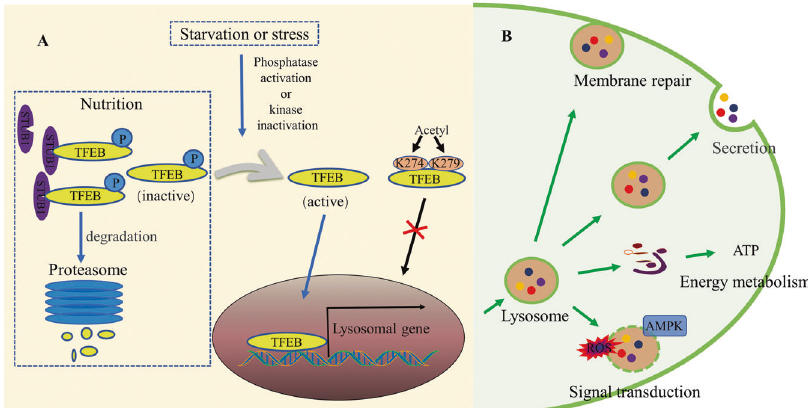
Fig. 1 Schematic diagram of TFEB regulation and lysosomal function. A Under physiological (nutrient) conditions, phosphorylated TFEB is inactive and degradation occurs via the proteasomal pathway. Under starvation or stress, TFEB is activated by kinase inactivation or phosphatase activation-mediated dephosphorylation, and is subsequently transferred to the nucleus to upregulate the expression of its target genes. TFEB acetylation at K274 and K279 blocks TFEB nucleation 28 – 31,33 . B Lysosomes have several biological functions, including membrane repair, secretion, energy metabolism, and signal transduction 1,13 – 23 . AMPK, adenosine 5 ′ -monophosphate (AMP)-activated protein kinase; ROS, reactive oxygen species; STUB1, STIP1-homologous U-Box containing protein 1; TFEB, transcription factor